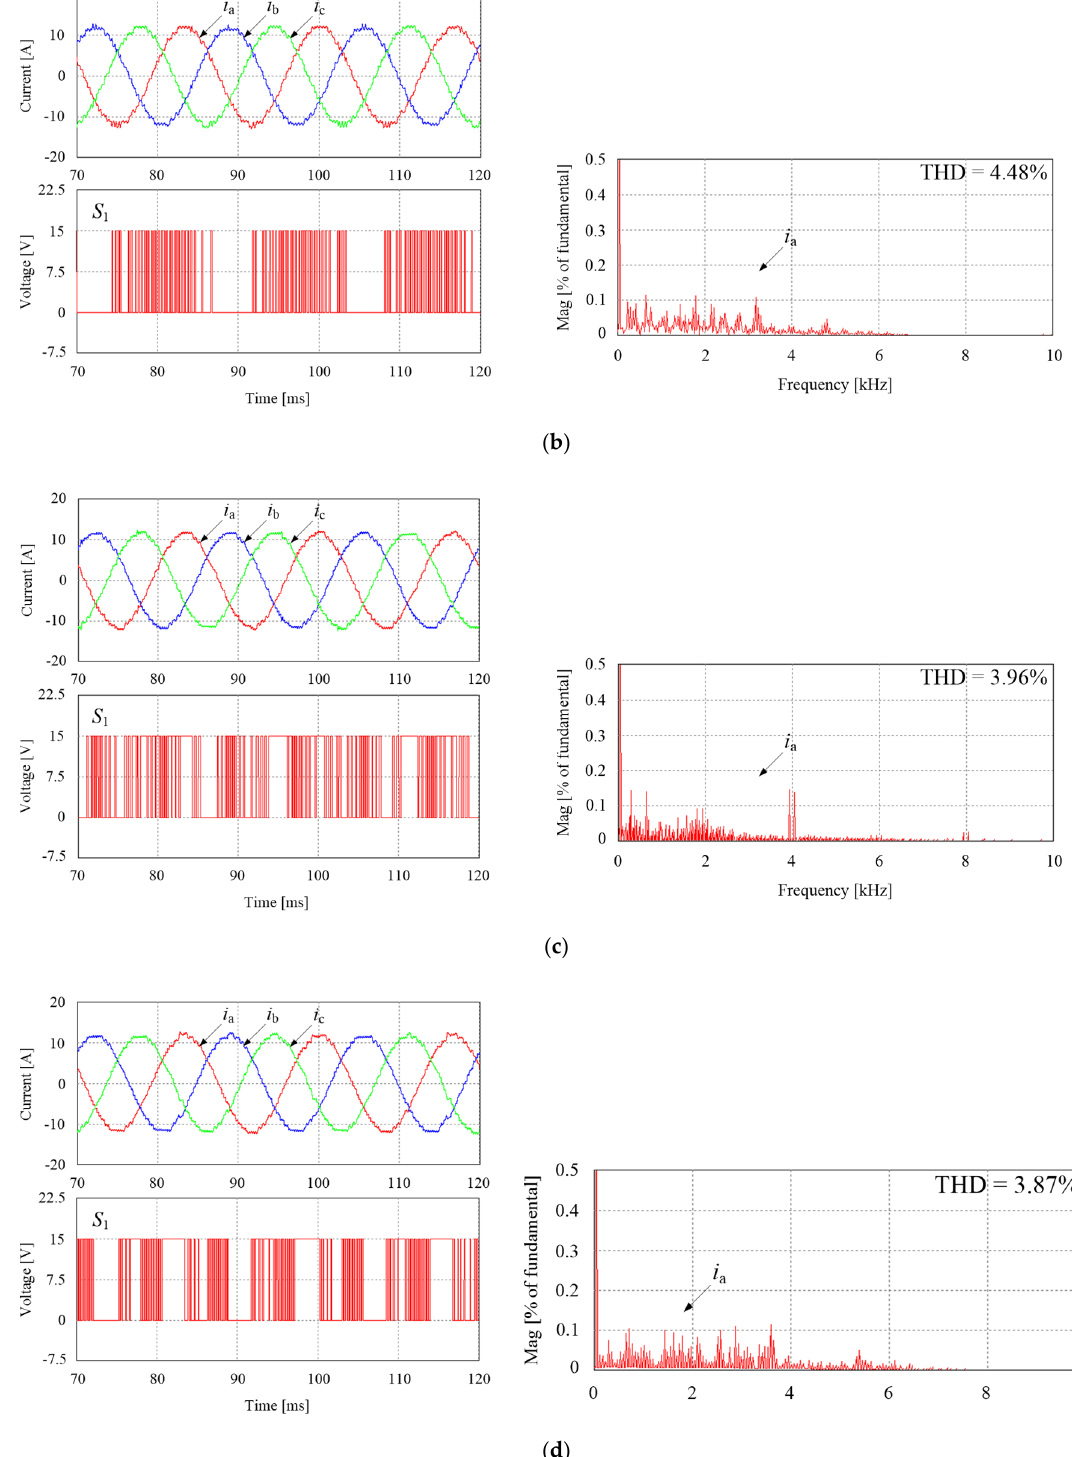
Figure 6. Simulation results of the three-phase output currents ( i a , i b , and i c ), a -leg upper switch S 1 , and the frequency spectrum of the a -phase current ( i a ) with | I * | = 12 A. ( a ) the conventional method using one vector with T s = 250 µ s, ( b ) the conventional method using one vector with T s = 125 µ s, ( c ) the conventional method using two vectors with T s = 250 µ s, and ( d ) the proposed method with T s = 250 µ s. THD: total harmonic distortion.